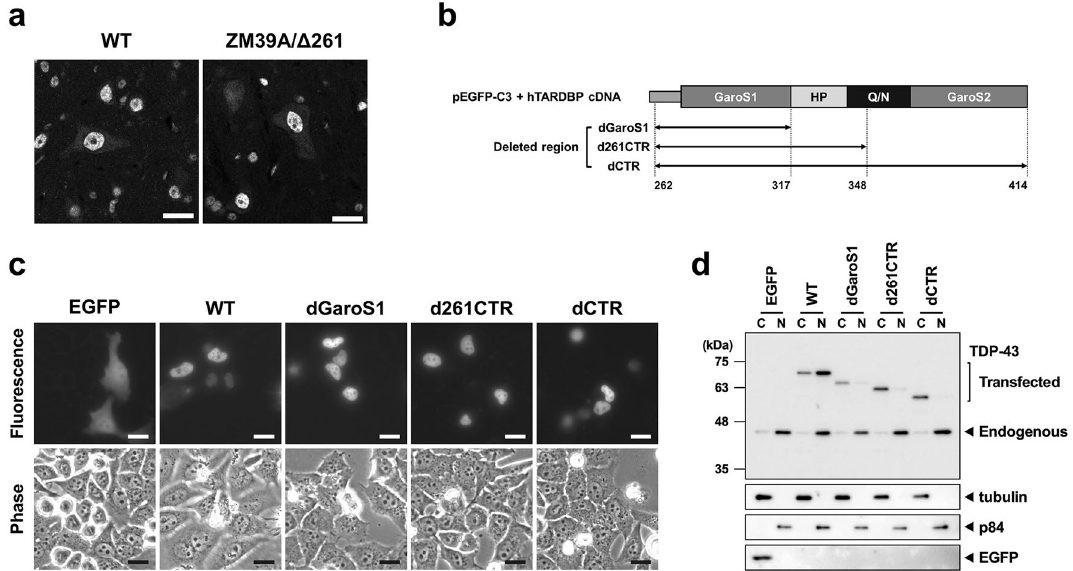
Figure 3. Subcellular localization of TDP-43 lacking various CTR deletions, including the GaroS1-HP segment. ( a ) Immunohistochemical analysis of the spinal anterior horn region in WT and ZM39A/Δ261 heterozygous mice stained with N-260 anti-TDP-43 antibody. Scale bar, 20 μm. ( b – d ) Transient expression of EGFP-tagged full-length human TDP-43 in HeLa cells. ( b ) Schematic diagram of full-length human TDP-43 constructs lacking dGaroS1 (aa 262–317), d261CTR (aa 262–346), or dCTR (aa 262–414). ( c ) Fluorescence and phase contrast images of living cells. Scale bar, 20 μm. ( d ) Cytoplasmic (C) and nuclear (N) fractions of cell lysates were subjected to western blotting using the antibodies indicated on the right. Note that the blot with the EGFP antibody shows only the low molecular weight region (approximately 27 kDa). Full-length blots are presented in Supplementary Fig.